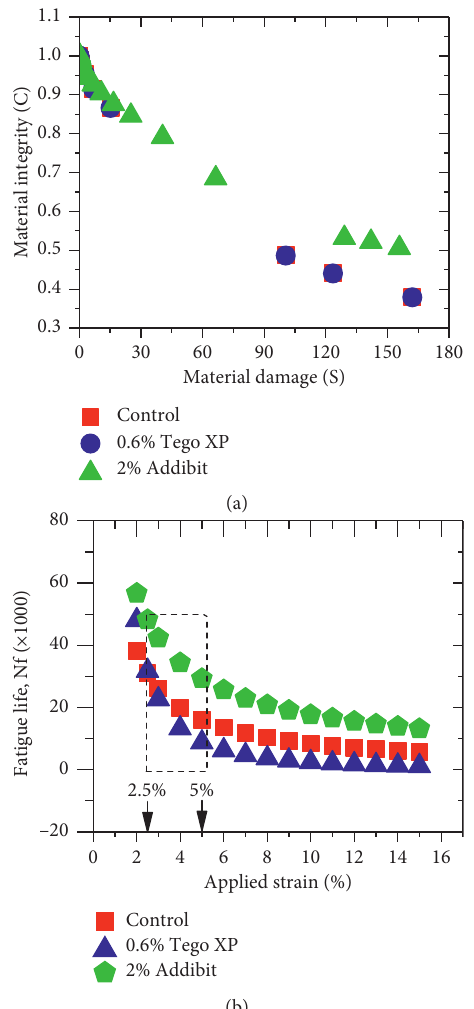
Figure 9: (a) VECD damage curve and (b) fatigue life ( Nf ) of CRM binders with and without WMA